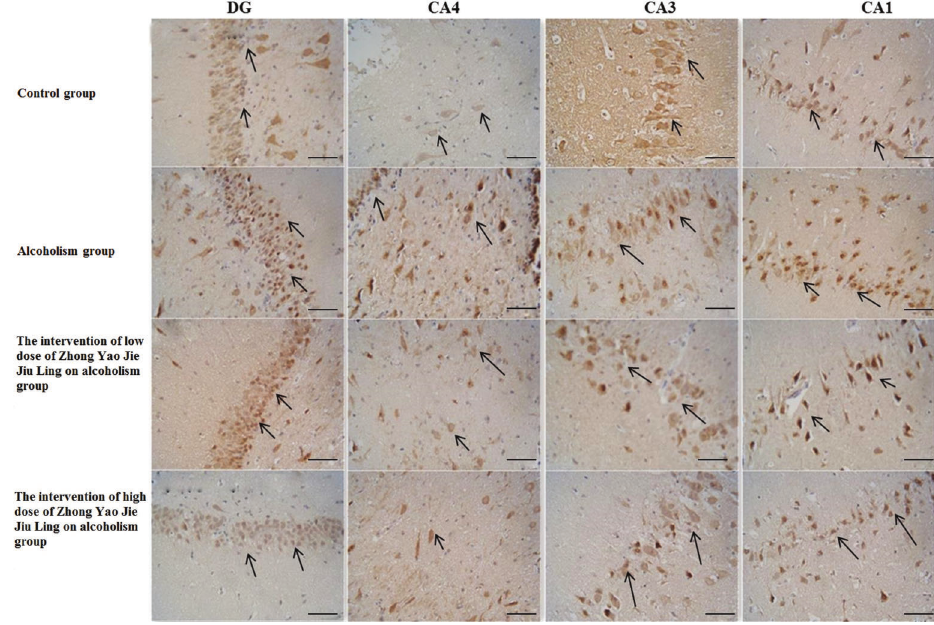
Figure 4. p75 neurotrophin receptor (p75NTR)-positive neurons in the dentate gyrus (DG) and hippocampus (CA4, CA3, and CA1) in the four groups (bars: 100 m m). The arrows indicate p75NTR-positive neurons.